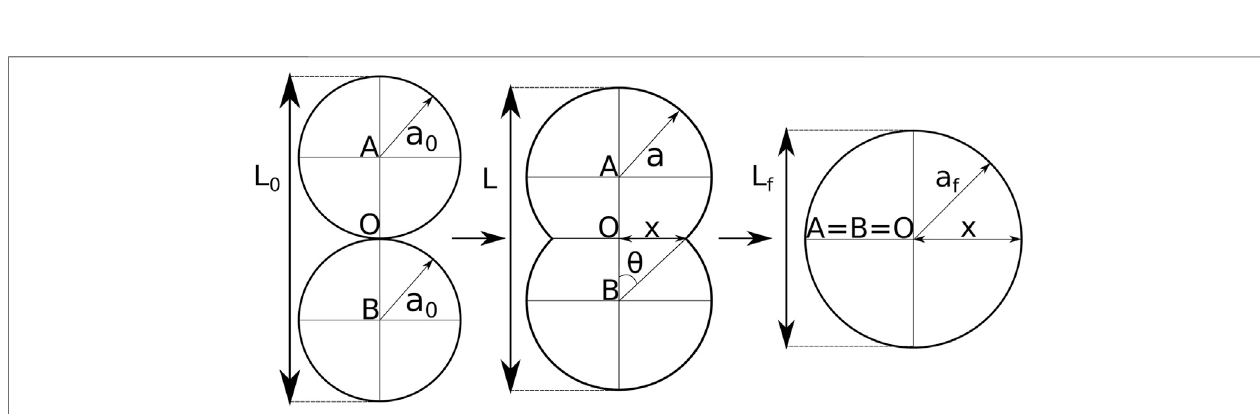
FIGURE 1 | Individual cell-based model of cell aggregation and spheroid fusion. First, gravitationally deposited cells aggregate in independent cylindrical wells for 24 h (top) . Next, two aggregates are extracted and combined in a single fusion simulation, which continues for a further 50 h (bottom) .